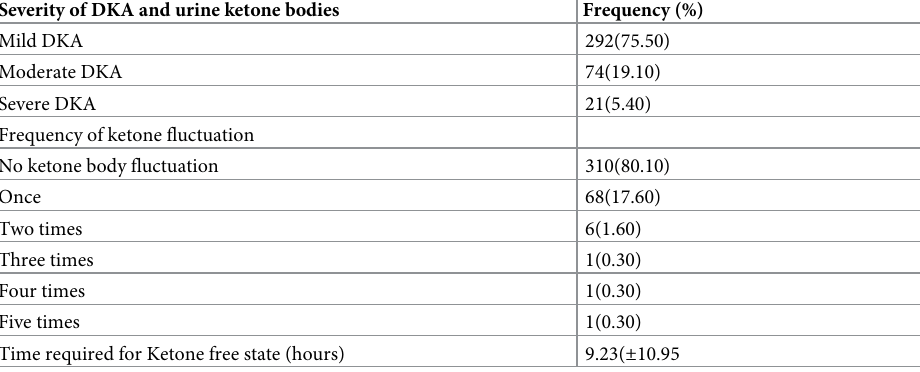
Table 3. Severity of DKA and ketone bodies among DKA patients admitted at DTGH from August 2010 to May 31, 2018(n = 387). Severity of DKA and urine ketone